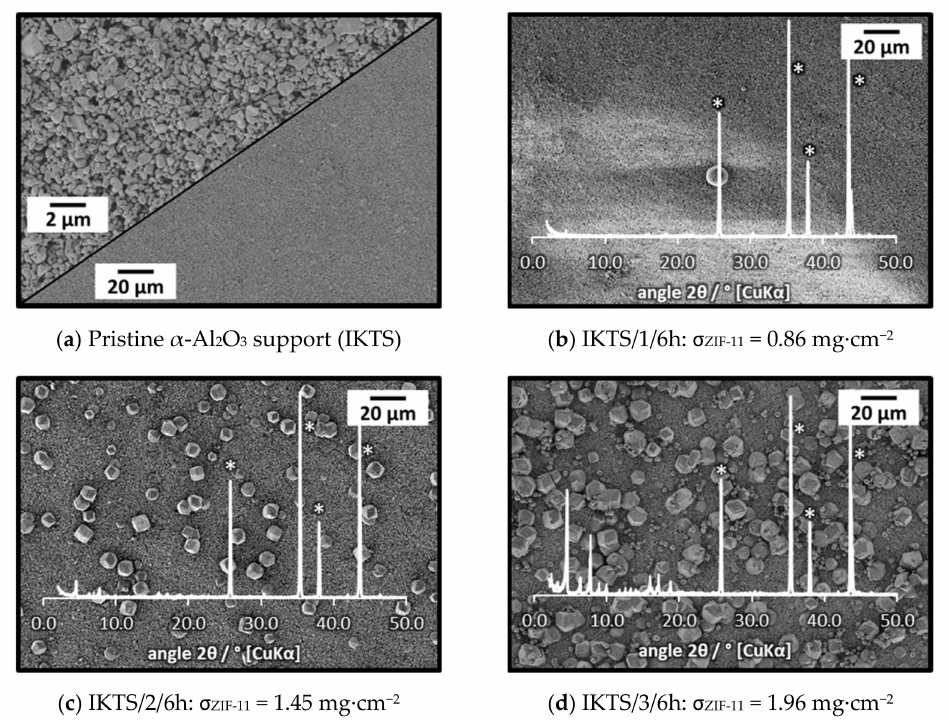
Figure 9. SEM images and XRD patterns of an α -Al 2 O 3 support (Fraunhofer IKTS) at different stages of ZIF-11 multiple in situ crystallization in DEF at 60 ◦ C (* support diffraction